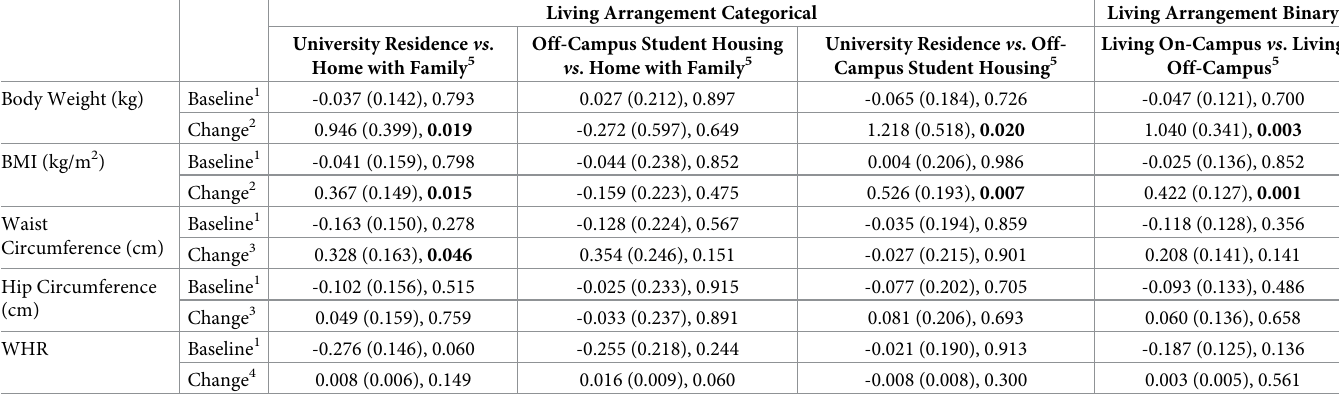
Table 3. Association between living arrangement and anthropometric traits in first year of